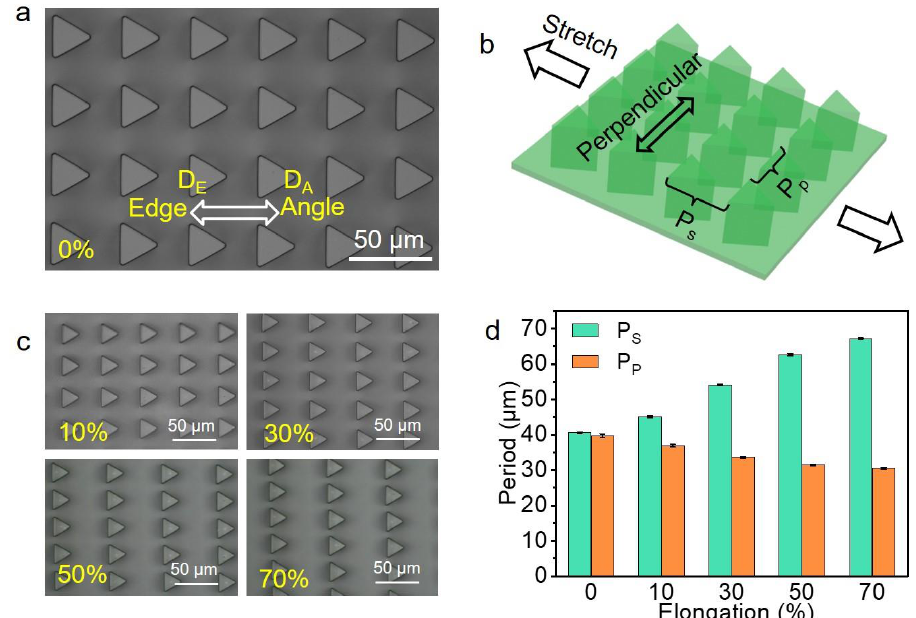
Figure 2. Surface topography of ATM. ( a ) Typical optical image of the resulted ATM with the definitions of directions of D A and D E ; ( b ) The definition of stretching and perpendicular directions with the corresponding period of P s and P p indicated; ( c ) Typical optical images at various stretching ratios; ( d ) The resulted P s and P p at various stretching ratios, each data point in ( d ) represents the mean value of at least 10 measurements. Standard deviations are indicated by error